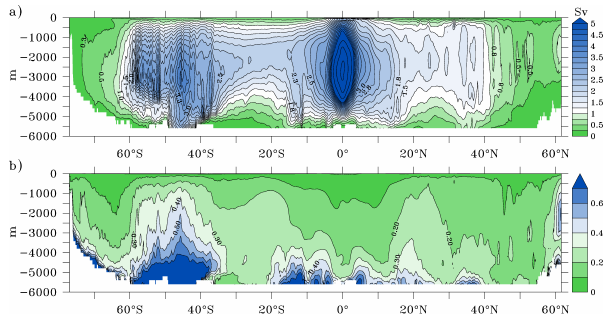
Figure 15: a) Unfiltered chaotic variability for global MOC. The contour interval is 0.25 Sv for values of Fig. 15. (a) Unfiltered chaotic variability for global MOC. The con- up to 5 Sv. For values higher than 5 Sv the contour interval is 1 Sv. b) Ratio between standard deviations tour interval is 0.25Sv for values of up to 5Sv. For values higher of chaotic and total global MOC. than 5Sv the contour interval is 1Sv. (b) Ratio between standard deviations of chaotic and total global